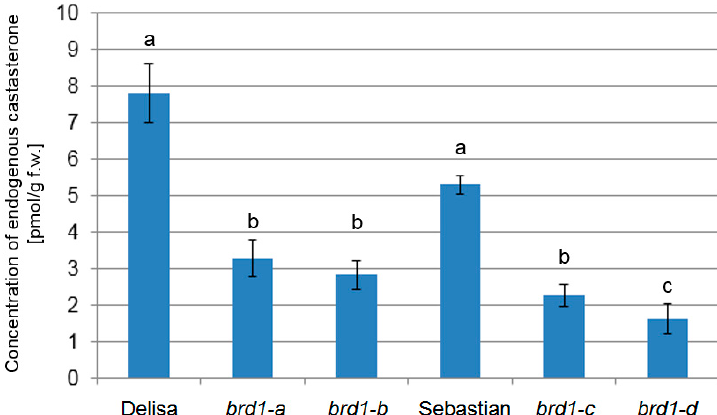
Figure 9. Concentration of endogenous castasterone measured in leaves of two-week-old seedlings. Mean values of three replications are shown with error bars representing standard deviation. Value obtained for each mutant was compared with its parental variety. The differences between values denoted by the same letter are not statistically significant ( p ≤ 0.05).